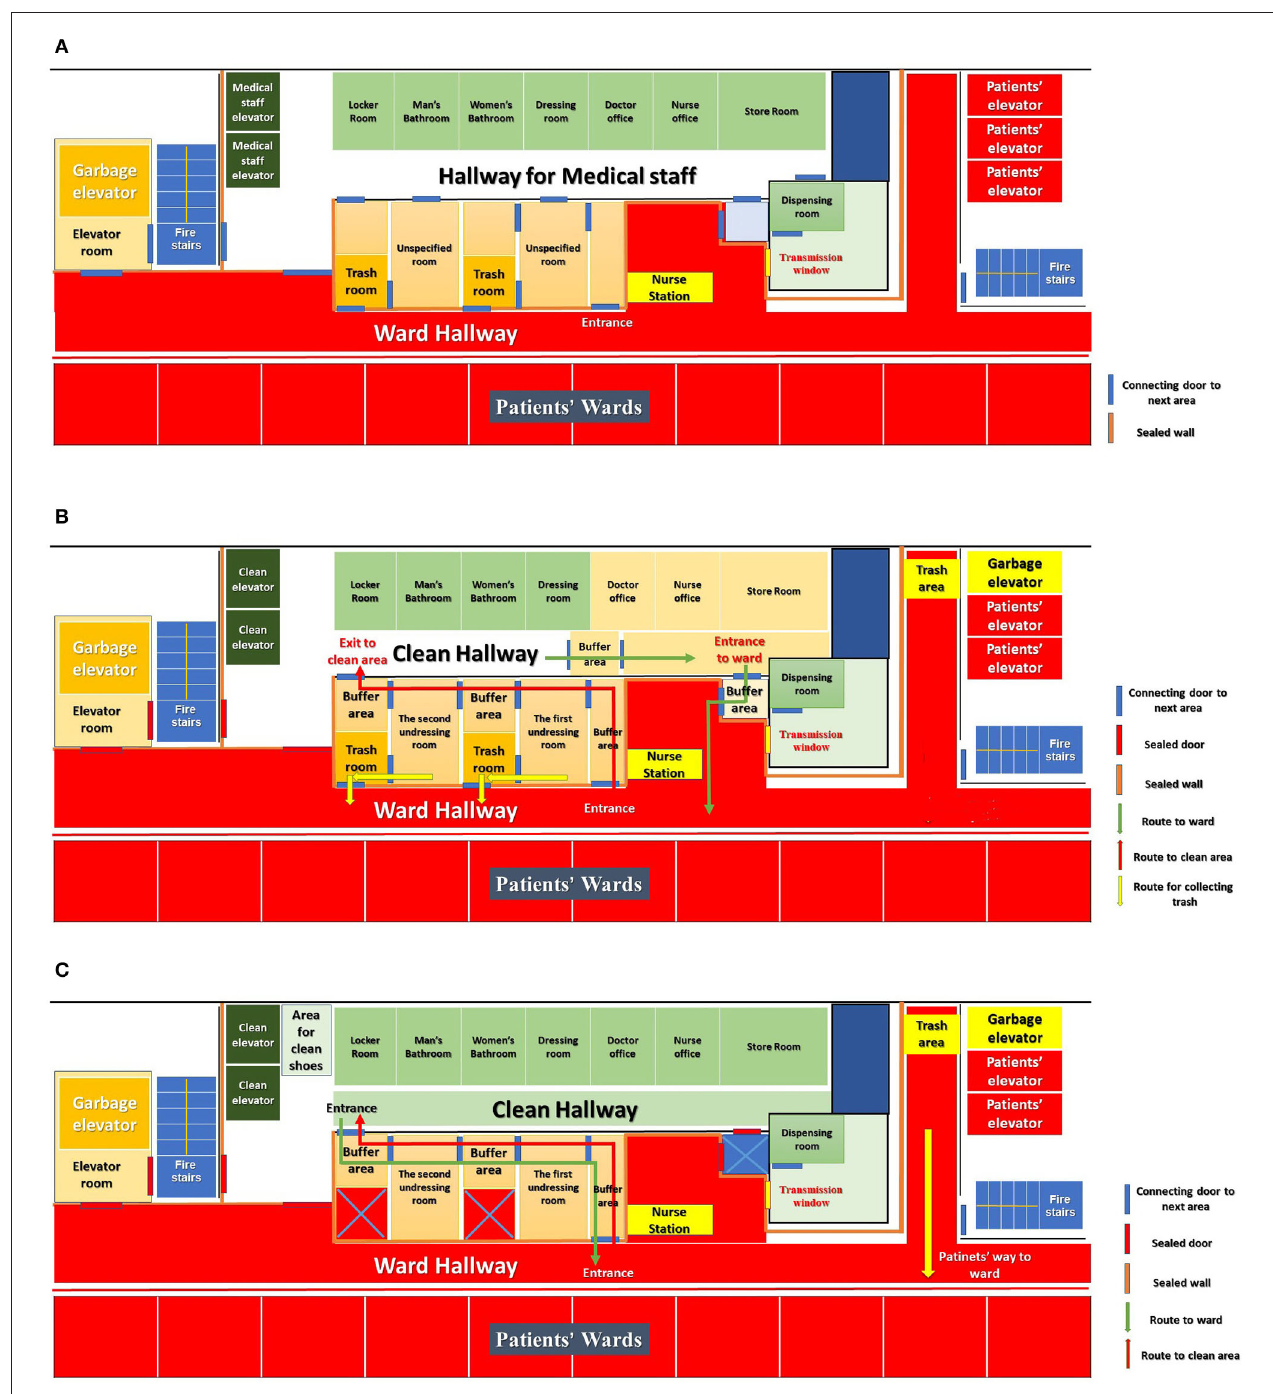
FIGURE 1 | Transformation of general wards into infectious disease wards. (A) The original plane graph of the general wards in the general hospital. (B) The standard reconstruction (STR) and working protocol of “Two-Pathway” transforming the general ward into infectious disease ward. (C) The simplified reconstruction (SIR) and working protocol of “One-Pathway” transforming the general ward into infectious disease ward.